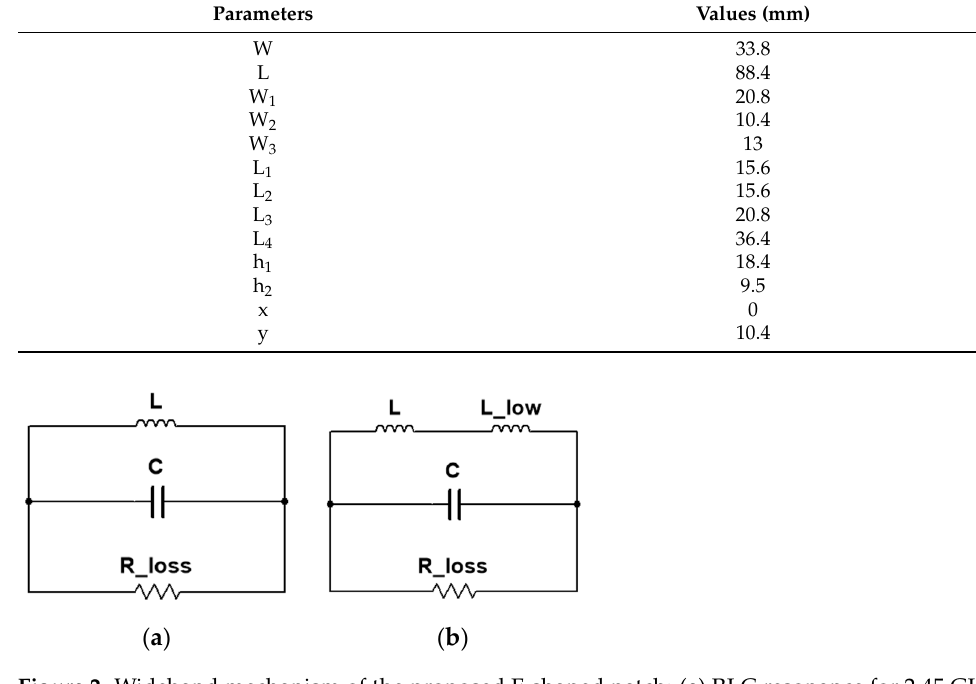
Table 1. Optimal parameters of the proposed antenna.